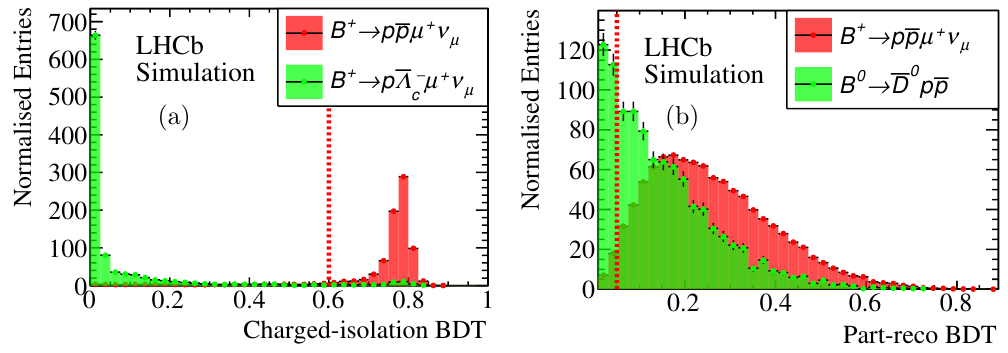
Figure 1 . Result of training (a) the charged-isolation BDT and (b) the part-reco BDT. The chosen selection on the classi(cid:12)er outputs are indicated by the dashed red line. For some candidates there are no additional tracks near the B -decay vertex; these candidates are accepted and do not appear in the charged-isolation BDT output. The background samples shown here have the (cid:3) (cid:0) hadrons decaying via (cid:3) (cid:0) ! pK + (cid:25) (cid:0) and D 0 ! (cid:22) + X . The part-reco BDT is trained on a c